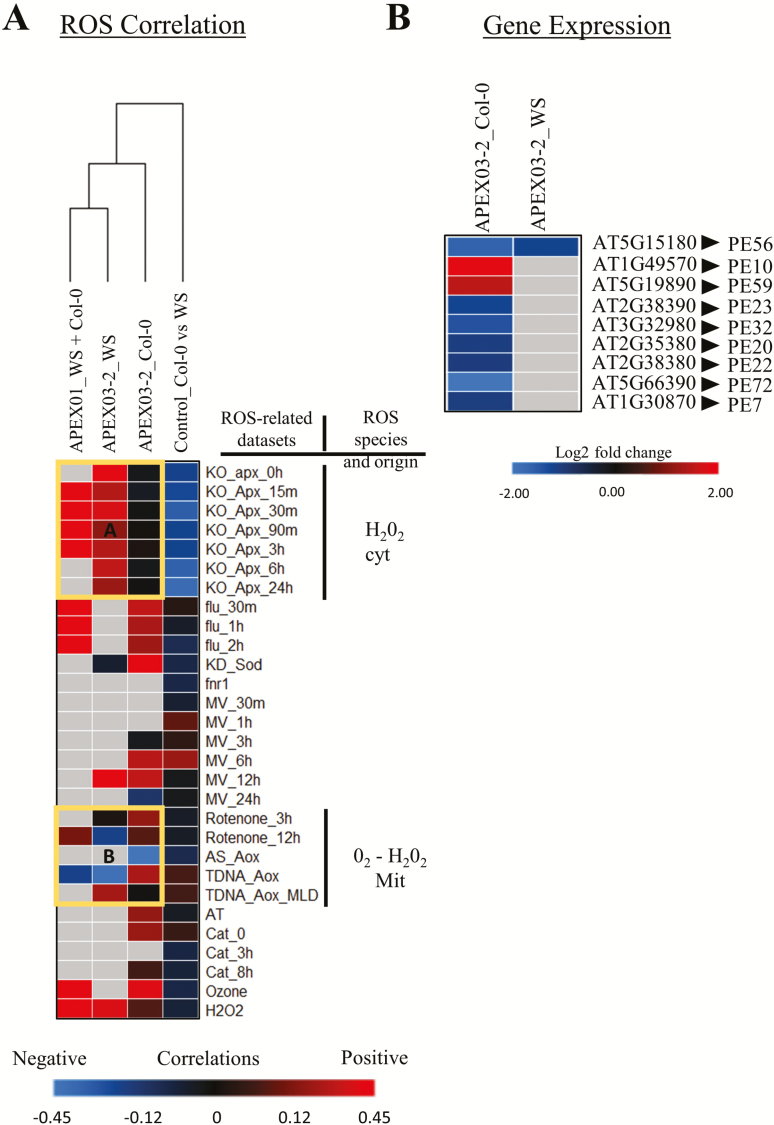
Correlations between spaceflight transcriptome and ROS-related microarrays revealed that ROS is induced in spaceflight in an ecotype-dependent manner. (A) The microarray (APEX01) and the RNAseq (APEX03-2) analyses of spaceflight transcriptional profile relative to the ground control profile were correlated to known ROS-related data sets producing specific ROS species from specific locations within the cell using the bioinformatics tool called ROSMETER (Rosenwasser et al. 2013). Positive correlations (red) show ROS production, whereas negative correlations (blue) show ROS scavenging. Black cells suggest no correlations, whereas gray cells indicate that there are insufficient gene numbers for a statistical correlation. Clusters highlighted in yellow boxes denote regions of interest. Group A showed that only the spaceflight transcriptome of WS positively correlated with the cytoplasmic ascorbate peroxidase knockout (KO-APX1) experiments, which represent cytoplasmic H2O2 ROS indices. Group B showed ecotype-related differences in the correlations associated with mitochondrial stress. (B) Peroxidase genes having statically (P < 0.01) differential expression (>1 or −1 < log2 fold) between spaceflight and ground control in both WS and Col-0 ecotypes are depicted. Blue is indicative of down-regulation, red is indicative of up-regulation and gray indicates no statistically significant differential expression.